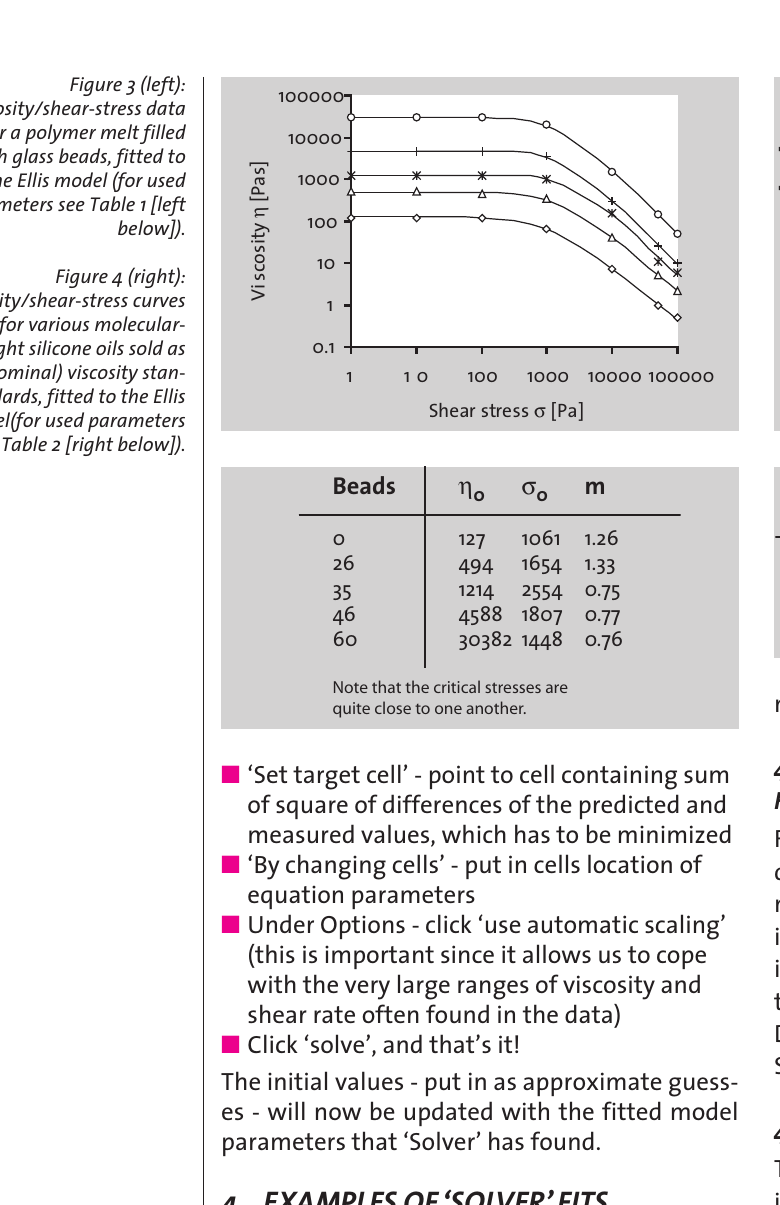
Figure 5 (left): Tooth- paste flow curve fitted to the Sisko model, using parameters k = 206.5, n = 0.1134, and h ∞ = 3.26 Pas. Figure 6 (right): Higher shear rate data for SUA1, fitted to the Sisko model, with k = 8.74 Pasn, n = 0.345, and h ∞ = 0.0143